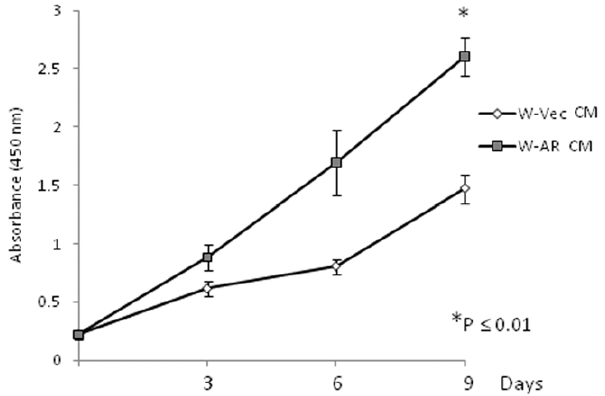
Figure 5. Growth curves of LNCaP cells in the presence of DHT- treated WPMY-AR conditioned medium (W-AR) or